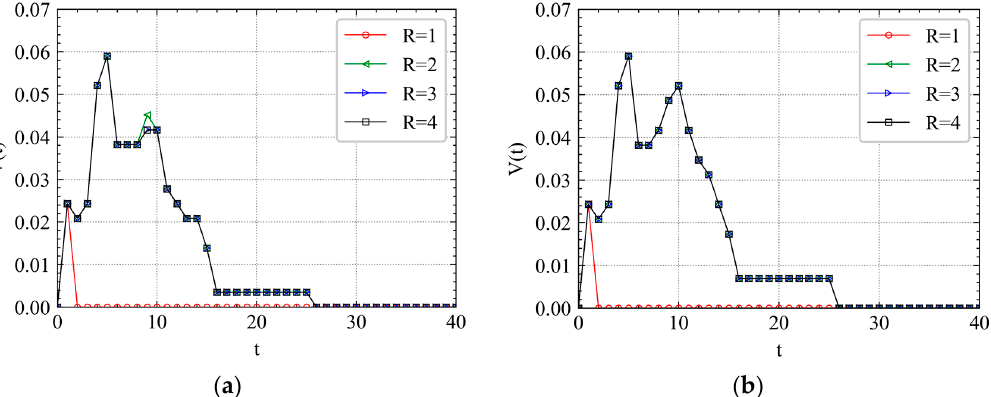
Figure 9. When the node with the largest degree is intentionally attacked, considering the heteroge- ε ε and 2 , the cascading failure spreading speed comparison CA, CMLs based on neity between 1 GAT,